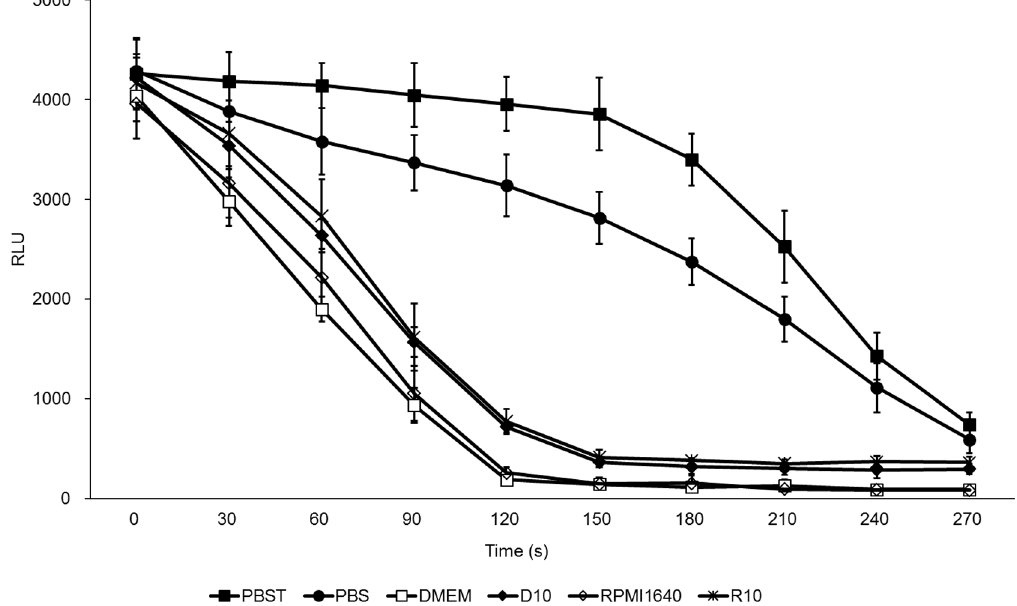
Fig 2. Comparison of light emission kinetics deduced from secNluc-catalyzed bioluminescence reactions in different buffers. In total, 5 ng/ml secNluc and 3 μmol/l coelenterazine were added to six buffers: DMEM, RPMI1640, D10, R10, PBS and PBST. The emitted bioluminescence at different time points (0 to 270 s at an interval of 30 s) was measured after the addition of coelenterazine in a 96-well plate by a Biotek Synergy 2 multi-mode plate reader (Biotek, USA). The data shown are the means ± standard errors of three independent